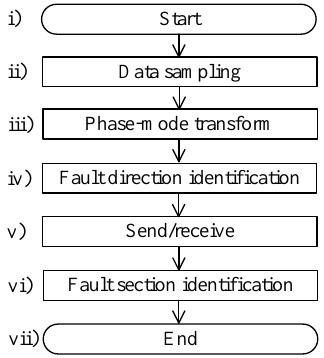
Figure 5. TW protection